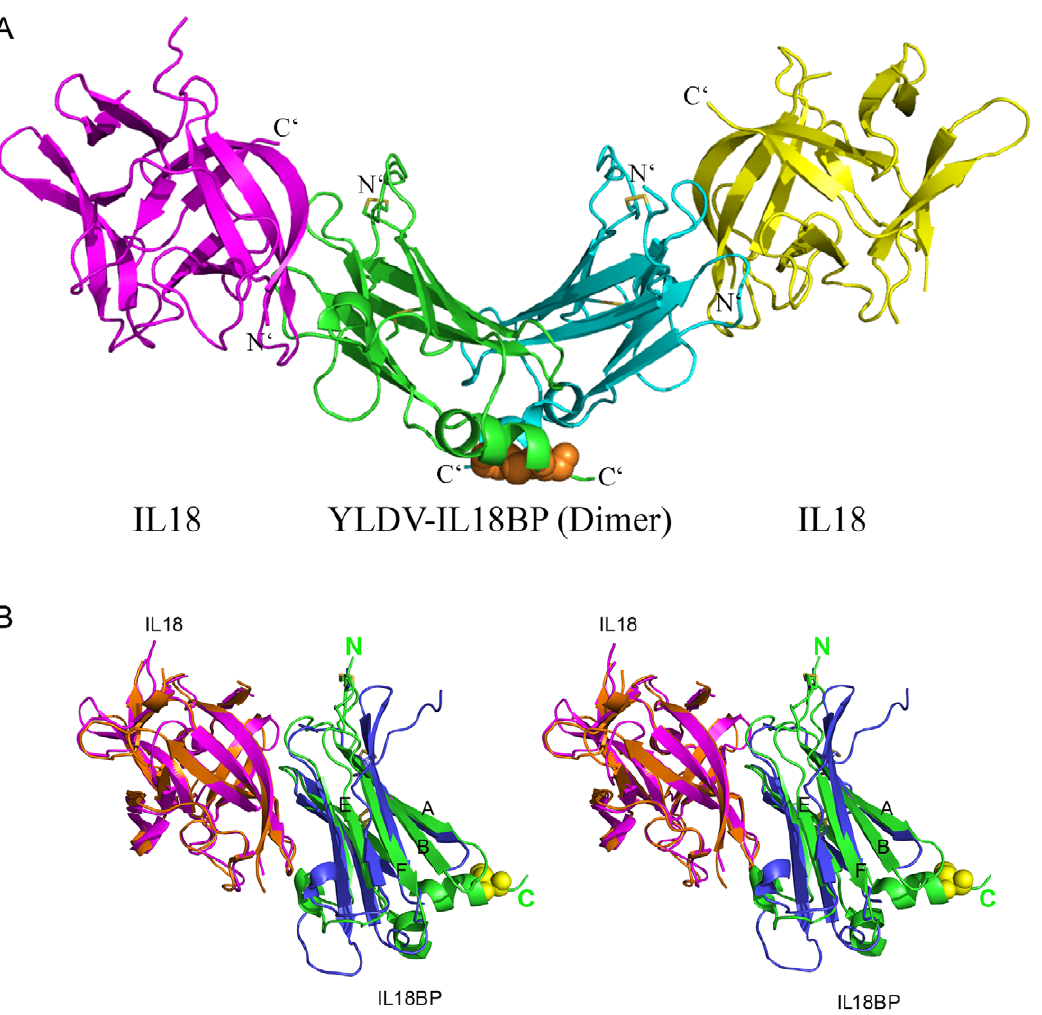
Figure 2. Overall structure of YLDV-IL18BP:IL18 complex. A). YLDV-IL18BP displays a homo-dimer (green and cyan), each adopting a b - sandwiched Ig-fold structure. Each protomer binds one molecular of IL18 (yellow and magenta), forming a 2:2 complex. The intra-chain disulfide bonds (SS) in YLDV-IL18BPs are shown as yellow sticks. The inter-chain SS bond at the C-terminus of YLDV-IL18BPs is shown as orange spheres. B). Stereoview of superimposition of the monomer complexes of YLDV-IL18BP (green):IL18 (magenta) and ECTV-IL18BP (blue):IL18 (orange). The N- and C-terminus of YLDV-IL18BP are indicated. The intra-chain SS bonds are shown as in A. Residue C132 is shown as yellow spheres. The b -strands A, B, E and F in YLDV-IL18BP are